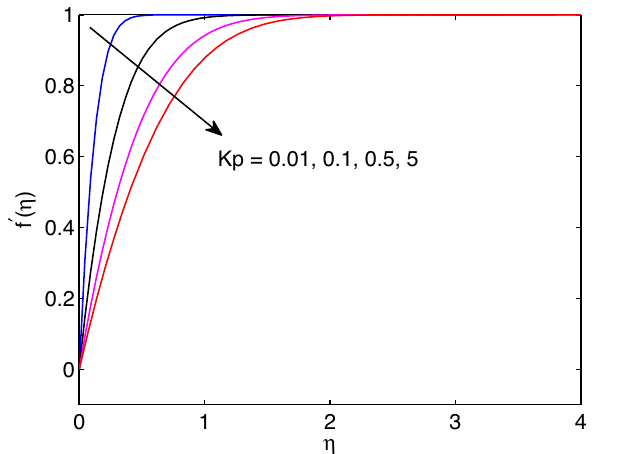
Figure 13. Permeability effects on velocity profiles.